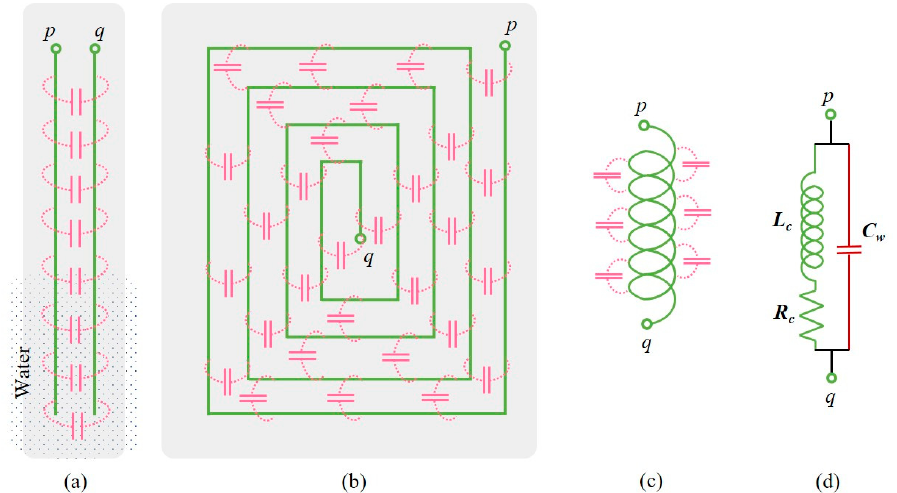
Figure 1. ( a ) Capacitive level sensor, ( b – d ) planar coil with parasitic capacitance and simplified electrical equivalent circuit.